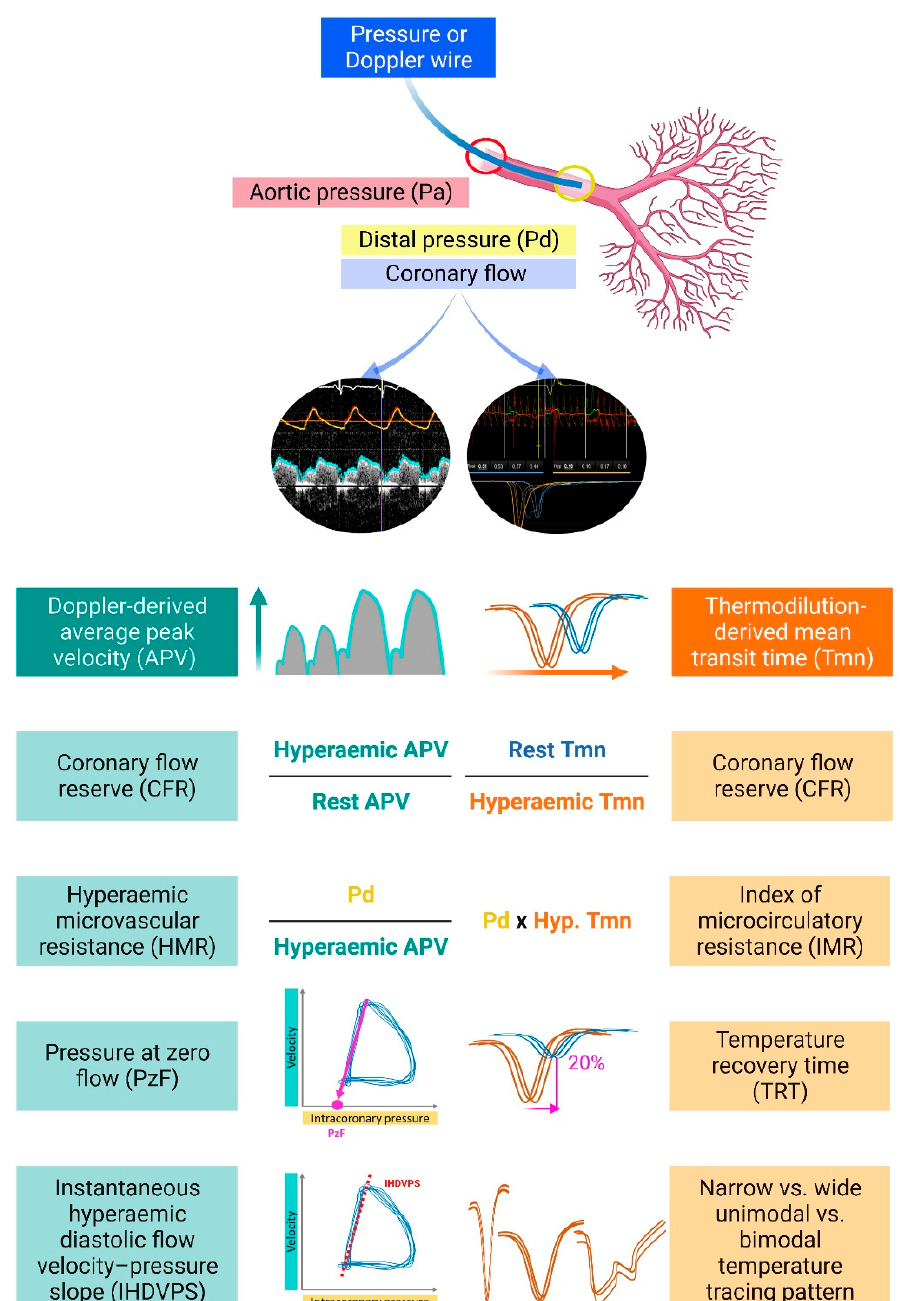
(Figure 2) including coronary flow reserve (CFR), index of microcirculatory resistance (IMR), hyperemic microvascular resistance (HMR), instantaneous diastolic flow velocity-pressure slope (IHDVPS) and pressure at zero flow (PzF).